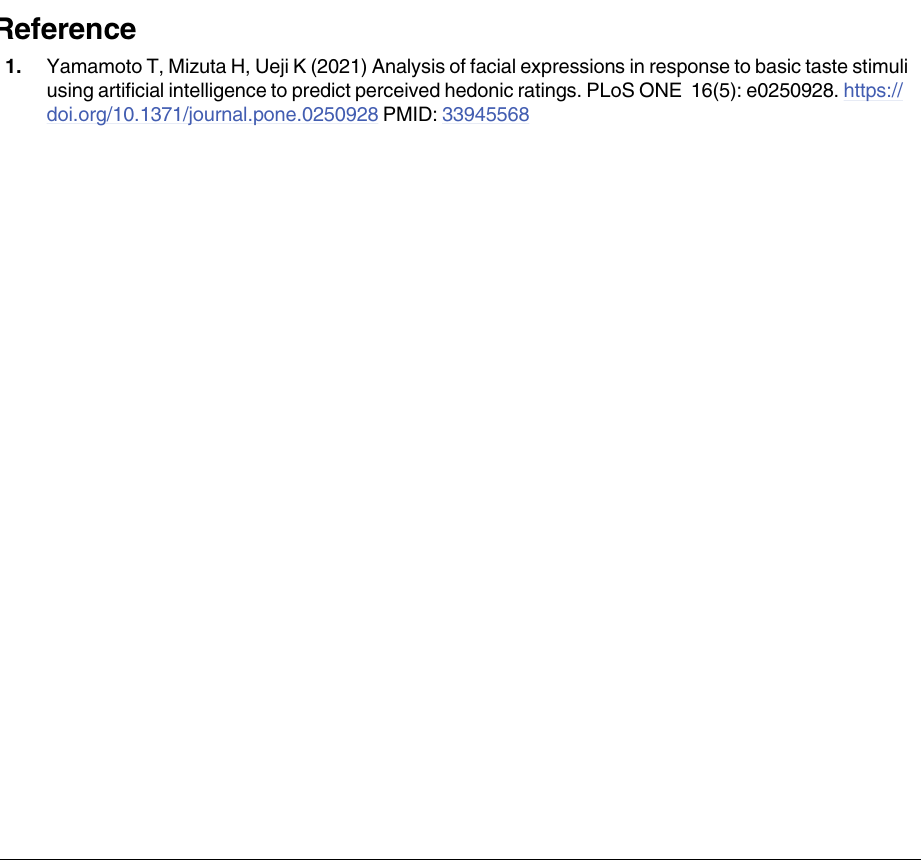
S2 Table. Raw data for Figs 4 and